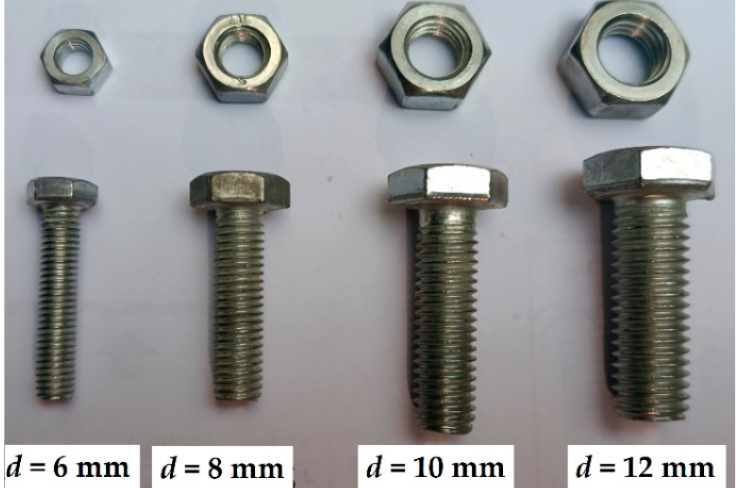
Figure 3. The connection bolts Grade 4.6 with nuts.